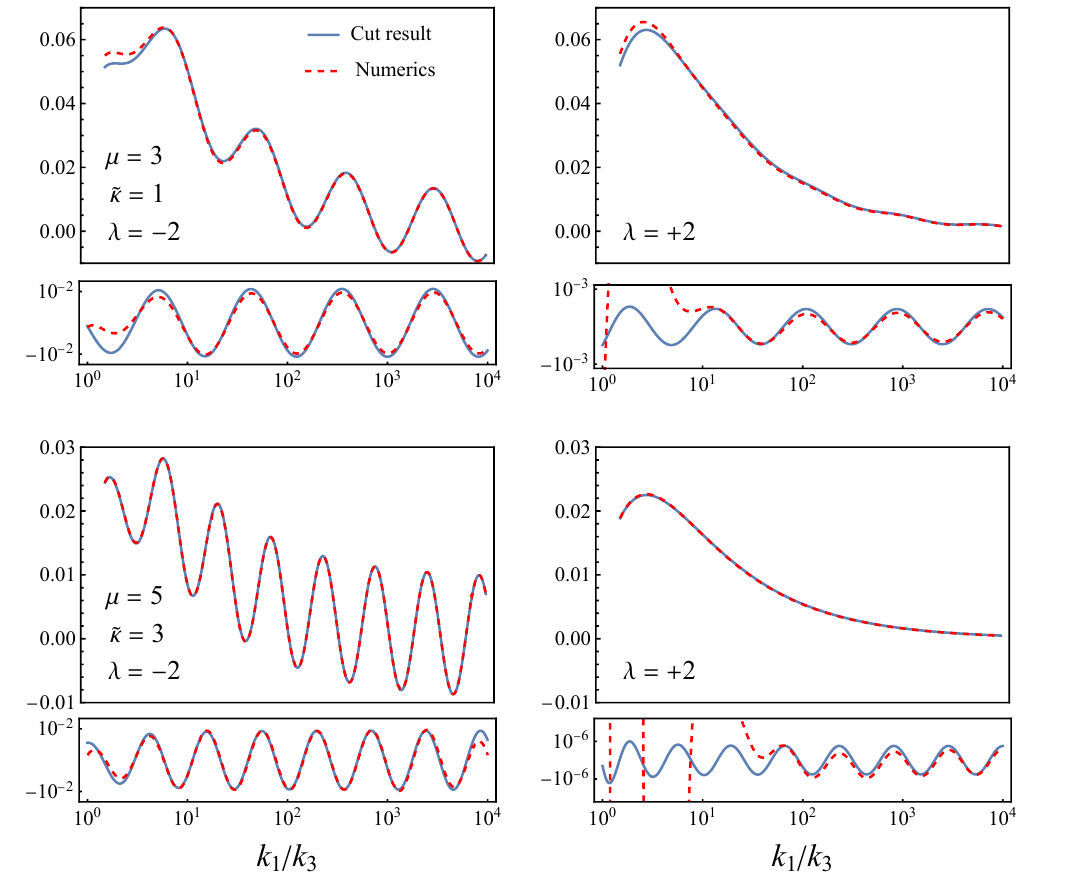
Figure 4 . The CC signals in the h ζζγ λ i correlator for different mass µ and chemical potential ˜ κ . The correlator is normalized by ( k 1 /k 3 ) 9 / 2 k 6 h ζ ( k 1 ) ζ ( k 1 ) γ λ ( k 3 ) i 0 / ρH 5 , with the upper panels 3 MM 2 p ˙ φ 0 showing the full result and the lower panels showing the oscillatory CC signal only. The blue solid lines correspond to the analytical cut result while the red dashed lines correspond to numerical results (the signals are filtered from the total numeric integration result using high-pass filters with a Blackman window